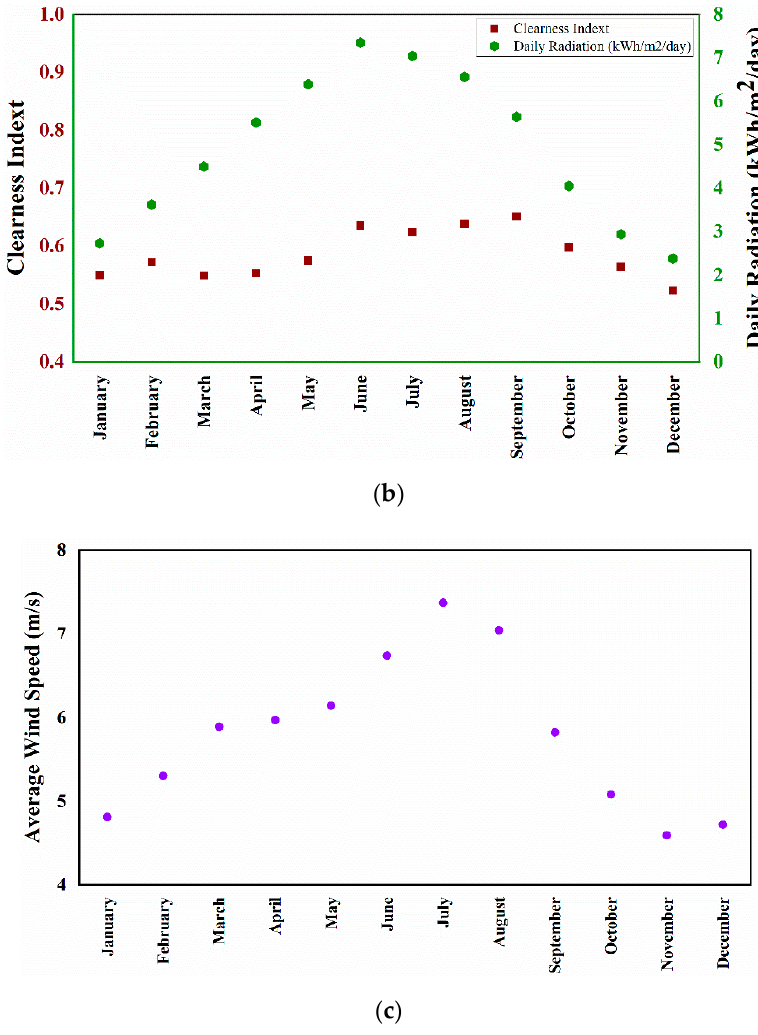
Figure 5. Weather data used for simulations ( a ) temperature; ( b ) solar irradiance; ( c ) wind speed .